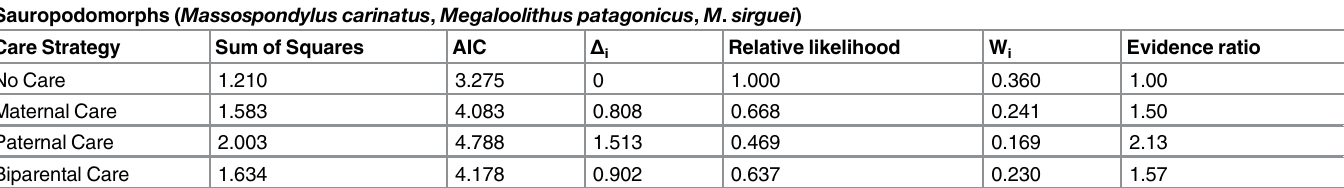
Table 9. Calculated likelihood that the sauropodomorphs for which clutch volume data exist show each parental care strategy.